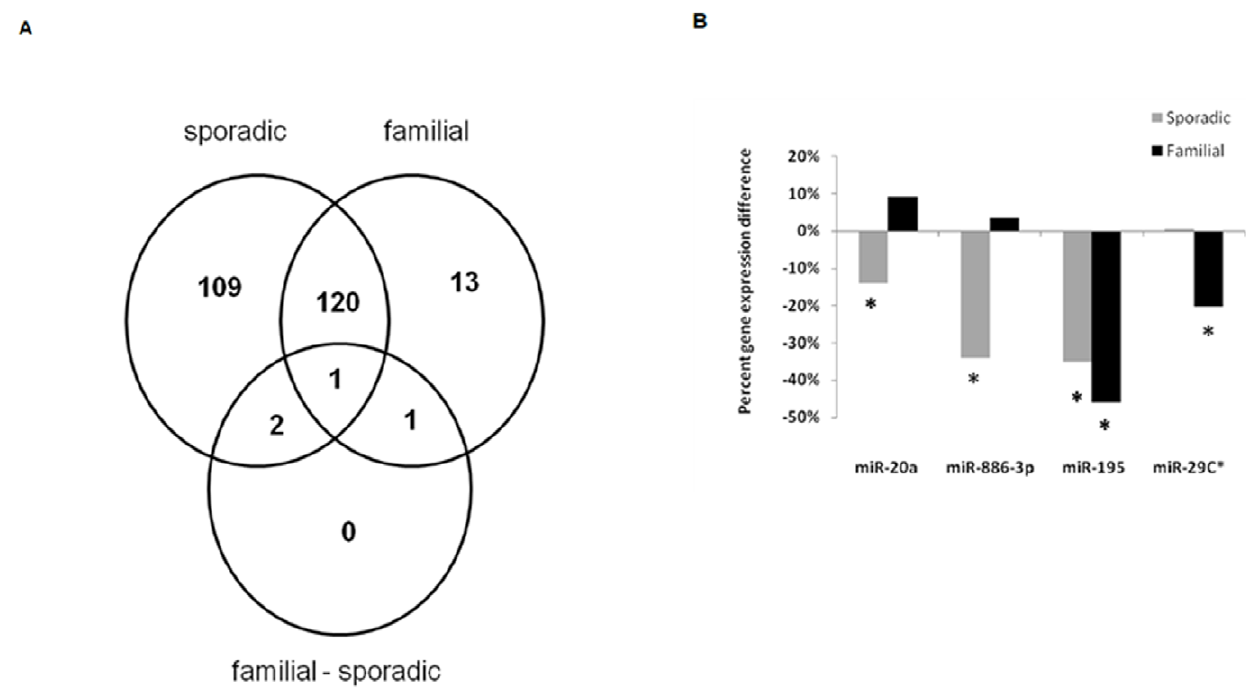
Figure 1. MiRNA expression in thyroid tissue. A ) Comparison of differentially expressed miRNAs in sporadic and familial papillary thyroid cancer compared to normal thyroid tissue. The sporadic circle indicates this group’s comparison to normal thyroid tissue, the familial circle indicates this group’s comparison to normal thyroid tissue, and the familial-sporadic circle indicates comparison between familial and sporadic tumors. B ) Relative percent miRNA expression difference between familial and sporadic tumors normalized to normal tissue samples. * p value , 0.05.